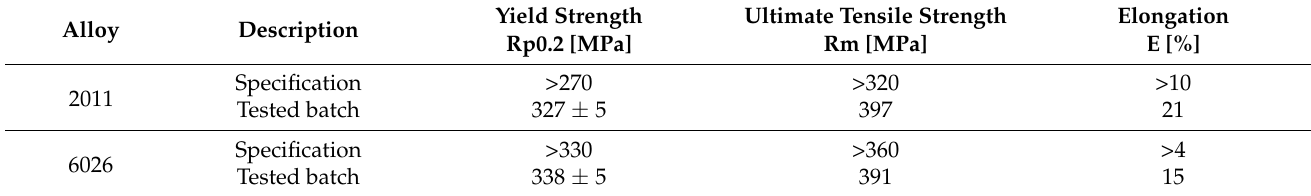
Table 5. Results of the tensile testing for the aluminum alloys employed in the study.